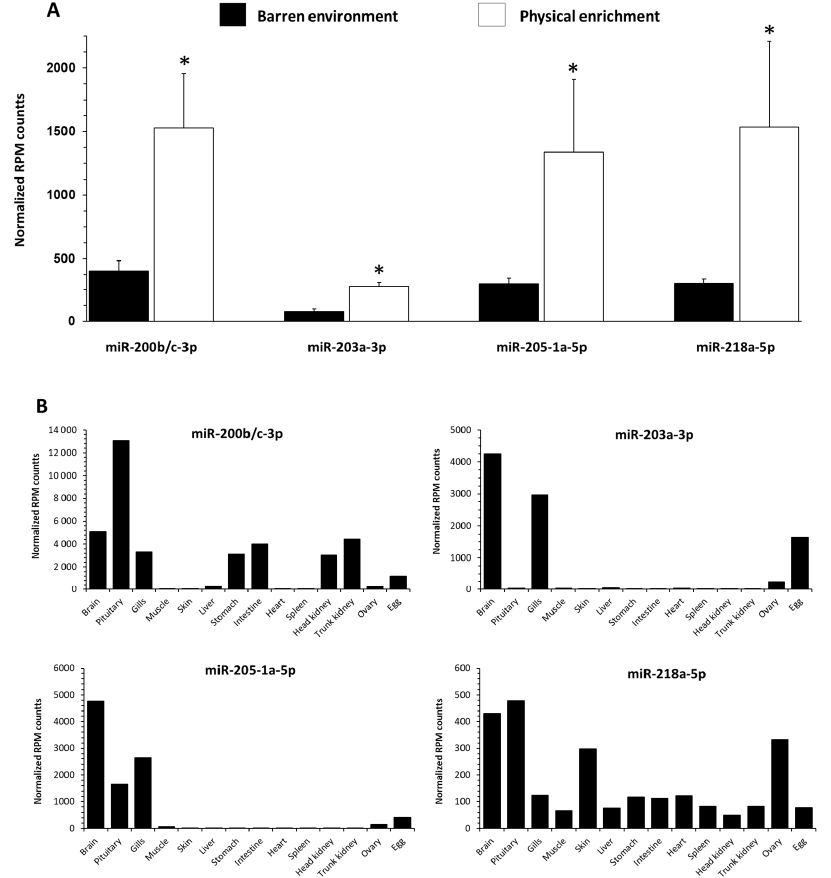
Figure 6. Abundance and tissue origin of c ‐ miRNAs differentially expressed in blood plasma of fish raised in a barren environment (black) or environmental enrichments (white) for three months. ( A ) Abundance of c ‐ miRNAs differentially expressed ( p ˂ 0.05, see asterisk) in blood plasma. Values are expressed as group mean ± SEM; differential expression analyses were performed using DESeq2 and raw counts from all fluid c ‐ miRNA expression data. For each differential expression test, log fold changes were corrected using lfcShrink (type = “apeglm”), and p ‐ values were corrected using an FDR method (correction of Benjamini ‐ Hochberg) to account for multiple testing. Replicates (n = 5 for EE treatment or 6 for BE treatment) correspond to different individual fish. ( B ) Abundance of c ‐ miRNAs differentially expressed in blood plasma in a panel of 14 tissues. Values are from small sequencing libraries of precedent studies